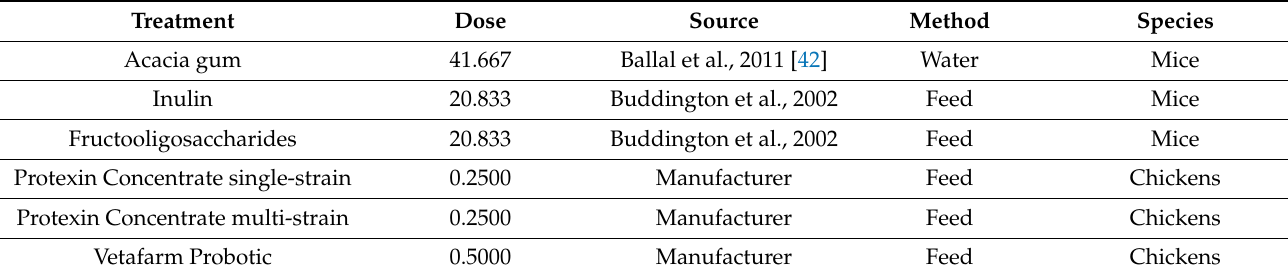
Table 1. Doses (mg/mL) of prebiotic compounds and probiotic formulas used for a screening experiment, and the source for each dose. Doses for prebiotics were calculated from the study doses using an average body weight of 100 mg per bee. Doses for probiotics were calculated from the manufacturer’s instructions, also using an average body weight of 100 mg per bee. All doses were prepared in 50% sucrose